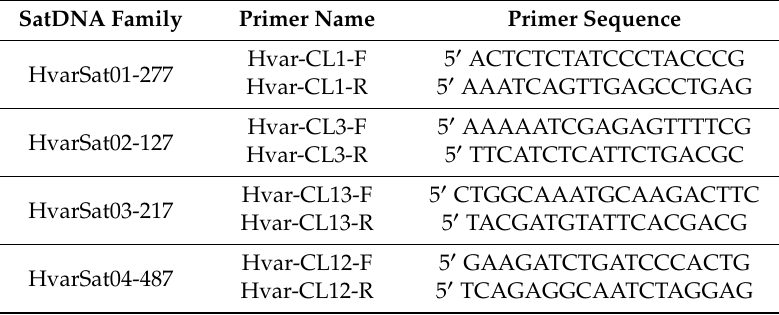
Table 1. Designed primers for PCR amplification of the four main satellite DNA (satDNA) families of Hippodamia variegata